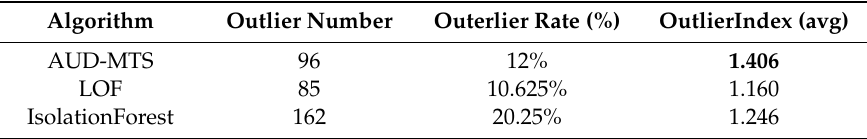
Table 5. The comprehensive performance of three outlier detection methods.